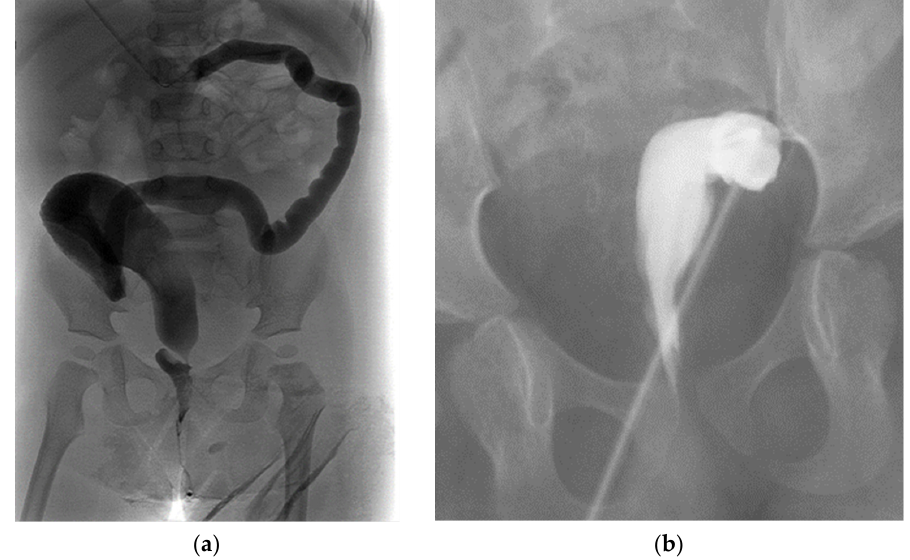
diversion (Figure 8b) [28].